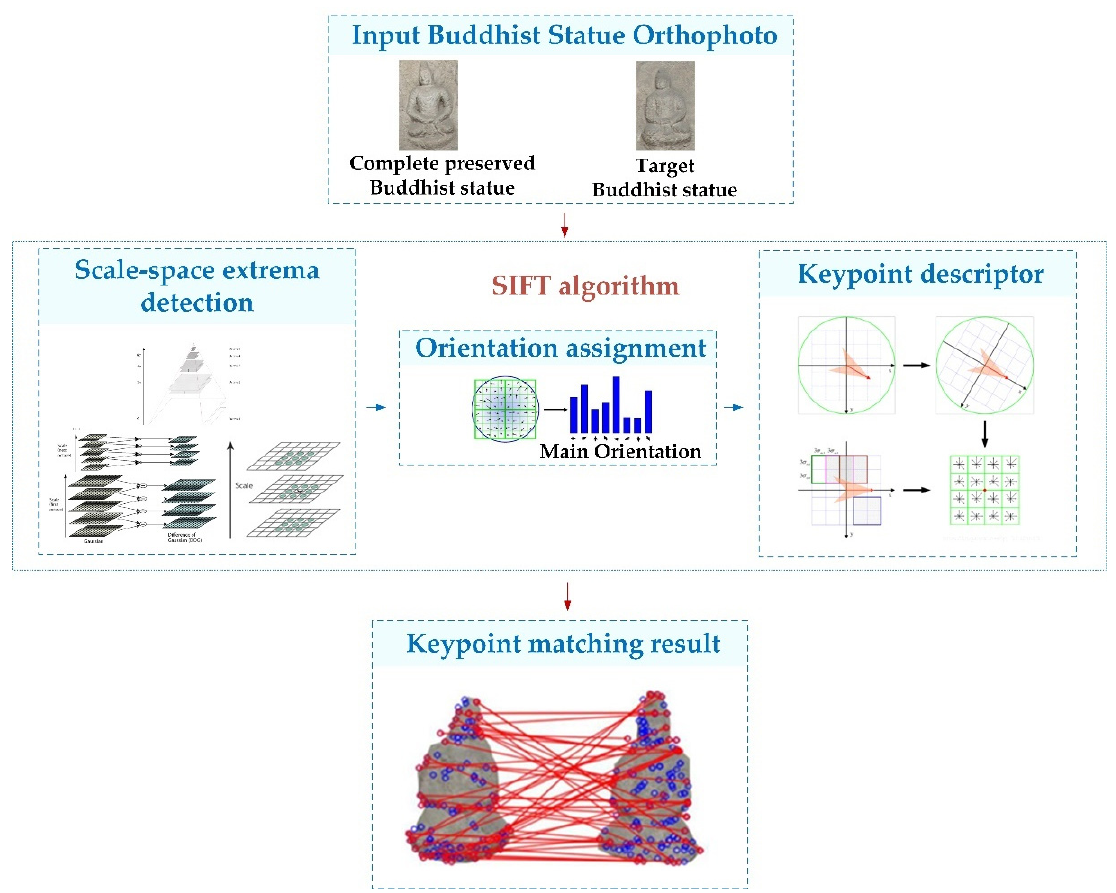
Figure 7. Flow chart of SIFT algorithm.